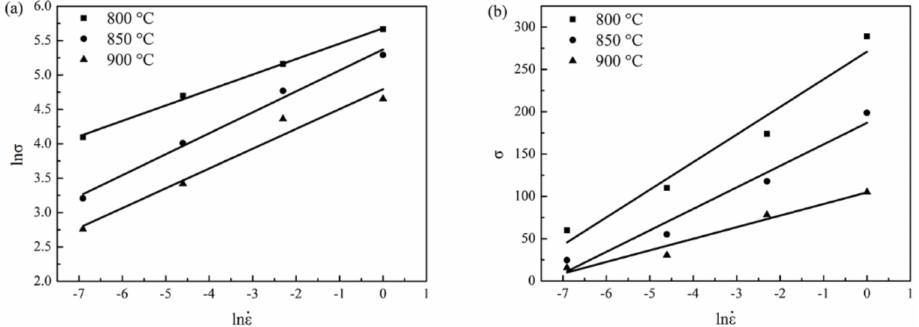
. ε . ε and ( b ) σ —ln in 800–900 ◦ C.